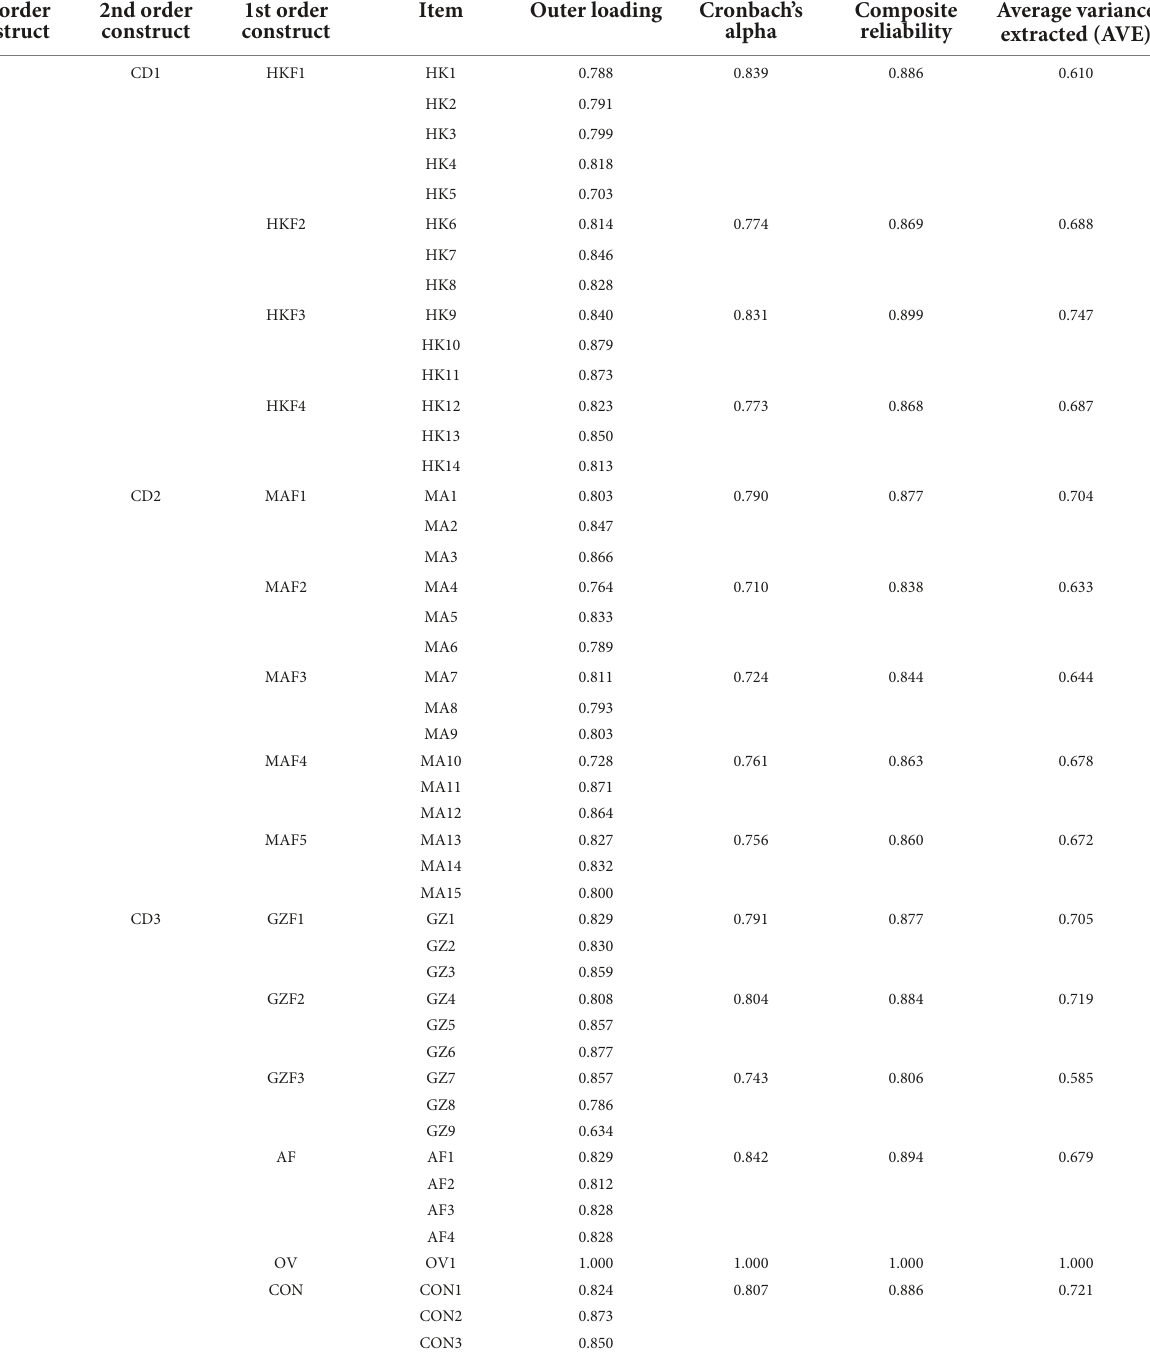
TABLE 3 Reliability and validity for first-order